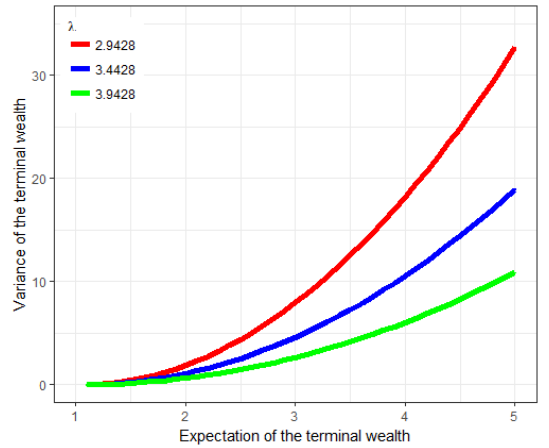
Figure 2. Effects of λ on the efficient frontier.